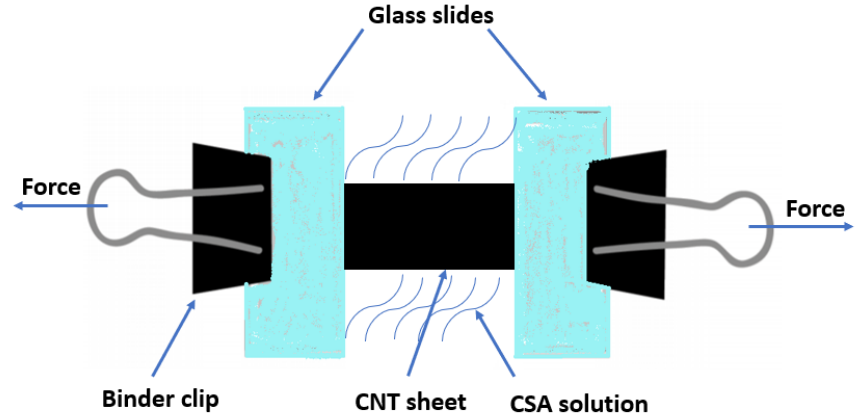
Figure 1. Schematic drawing of the stretching process.